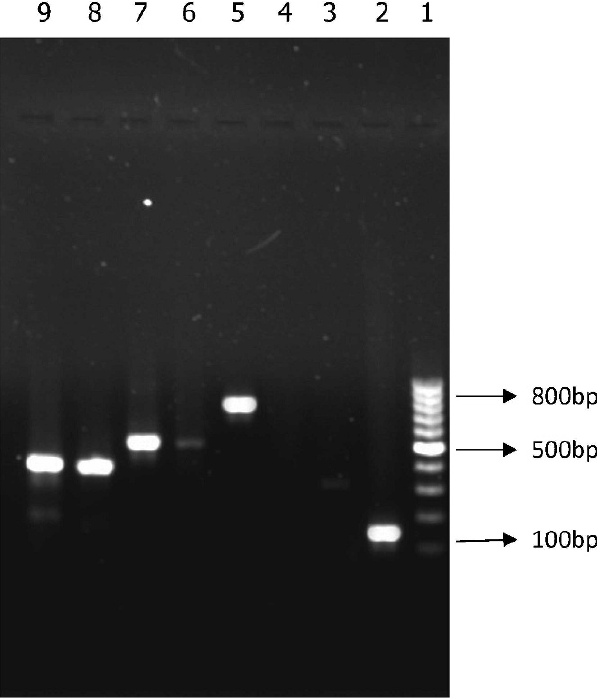
Figure 2 - Lane 1, 1000 bp DNA size marker; Lane 2, aac (6 9 )-II (125 bp); Lane 5, aph (3 9 )-VI (800 bp); Lane 7, ant (2 0 )-I (524 bp); Lanes 8 and 9, aac (6 9 )-I (392 bp).